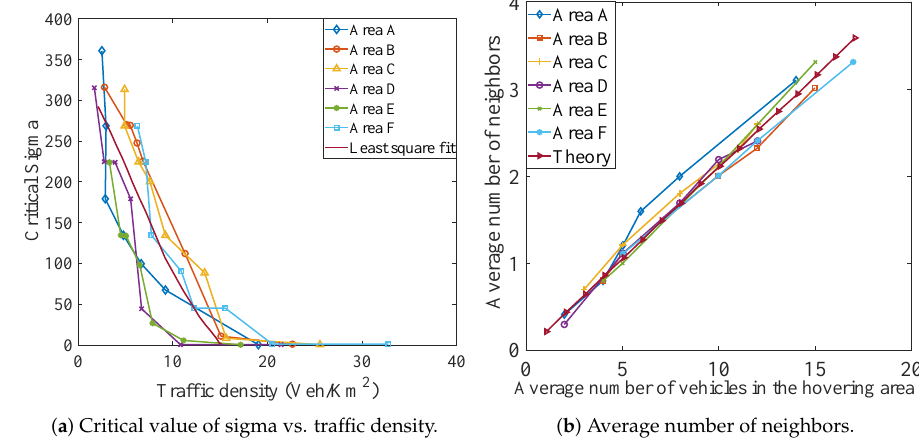
Figure 6. Reachability vs. the number of messages exchanged for different values of σ in areas B and C.